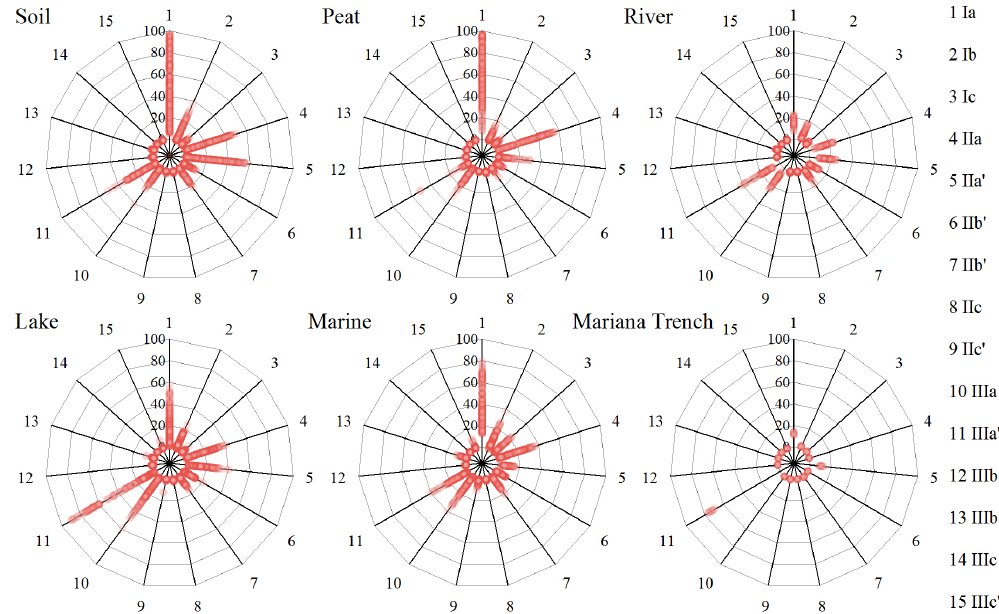
Figure 5. Comparisons of distribution of 15 brGDGT compounds in soil ( n = 634), peat ( n = 473), river ( n = 88), lake ( n = 410), marine ( n = 415), and Mariana Trench ( n = 11) samples.